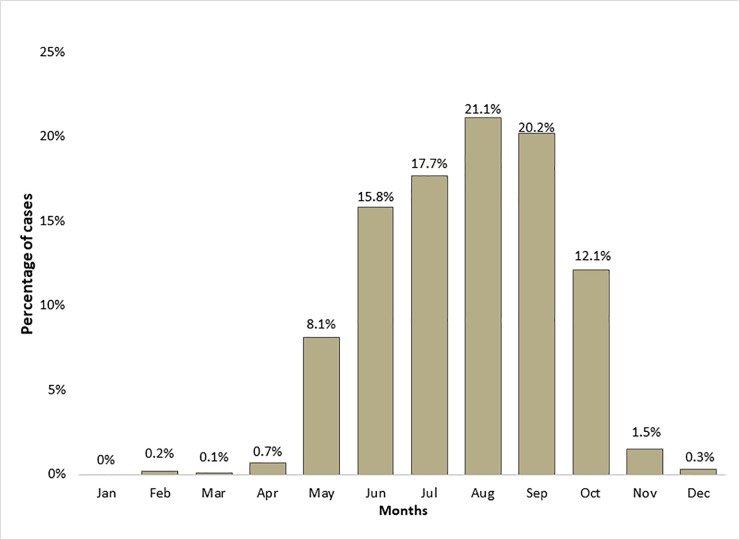
Average TBE seasonality by months (period 2007–2016;n = 1929).